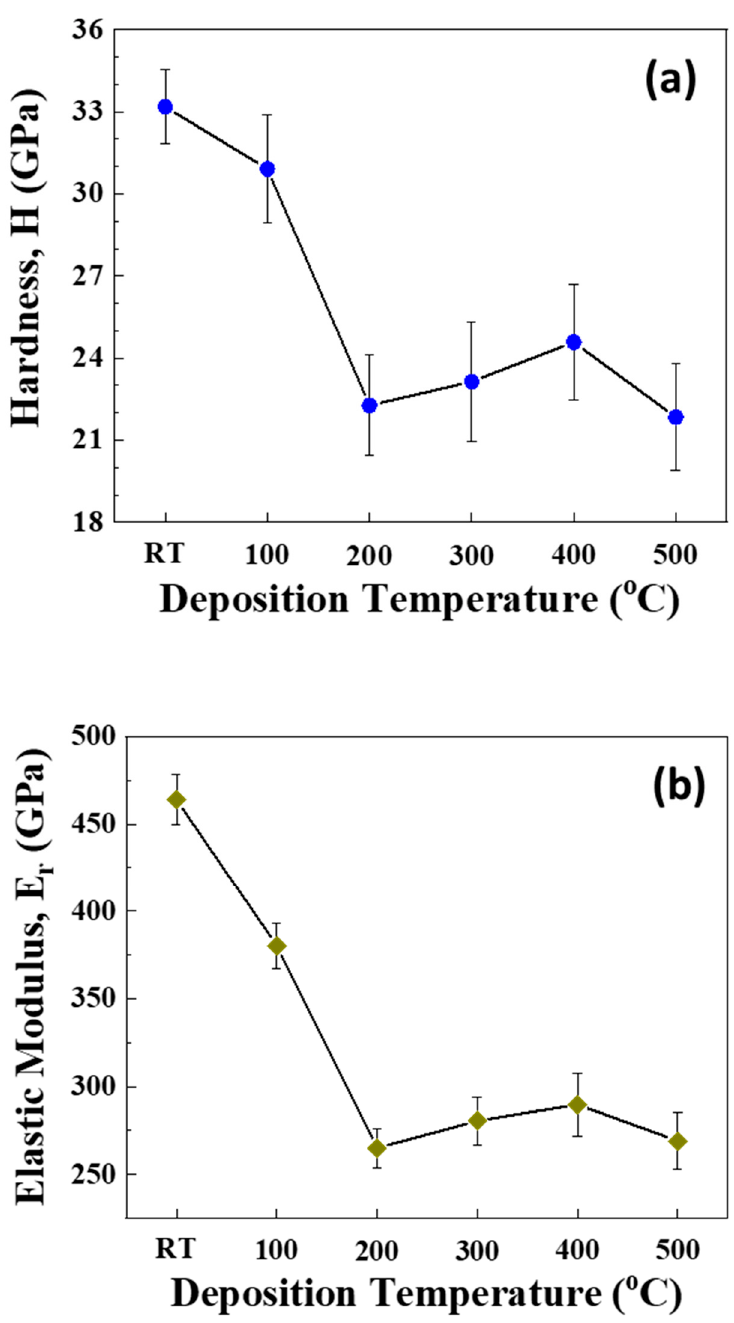
Figure 9. The variation of ( a ) hardness and ( b ) elastic modulus of Mo films with deposition temperature. The higher values of hardness and elastic modulus for Mo films deposited at 25–200 ◦ C are due to the size reduction effect while the decreases observed for Mo films deposited at 200 ◦ C are due to the increase in average crystallite size. Similar trend in both sets of values are indicative of the interconnected nature of these properties.